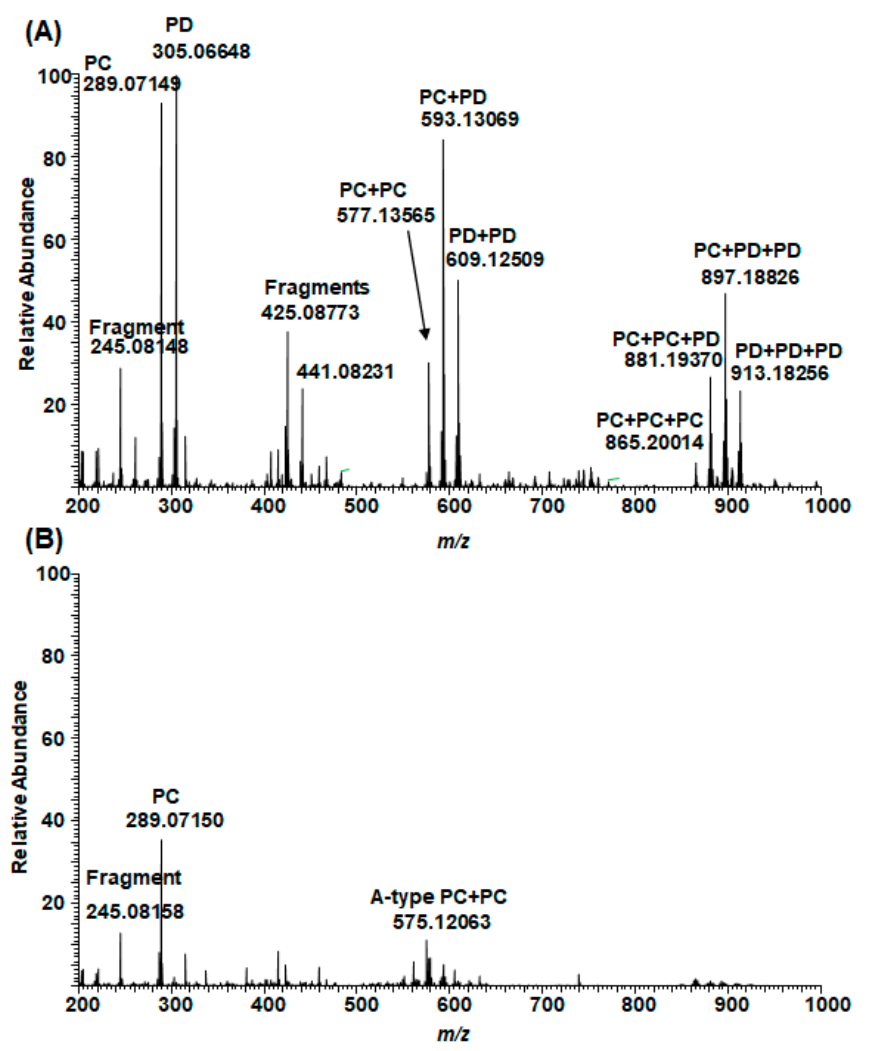
Figure 10. The mass spectra of small mixed B-type oligomeric procyanidins (PCs) and prodelphinidins (PDs) in the non-oxidized ( A ) and oxidized ( B ) leaf extract of Podocarpus macrophyllus . The exact masses of main ions are listed in Table S4. The abundances of the ions are fixed to normalized intensity of 6.9 × 10 6 .